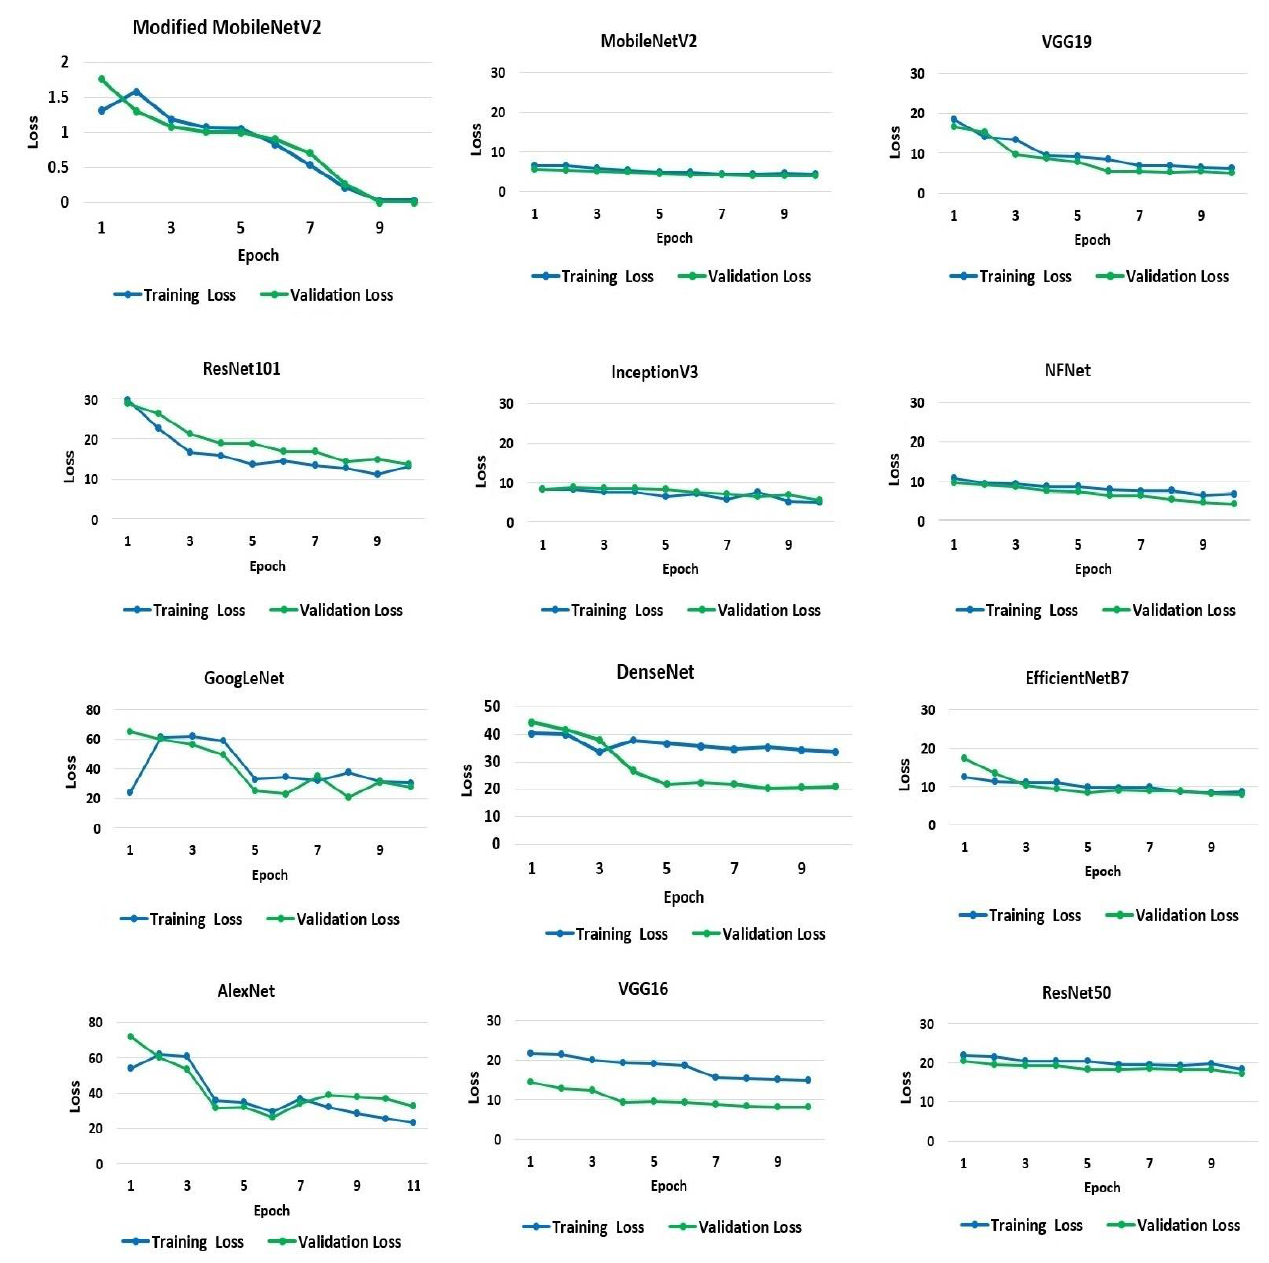
Figure 5. Loss in training and validation of the models.